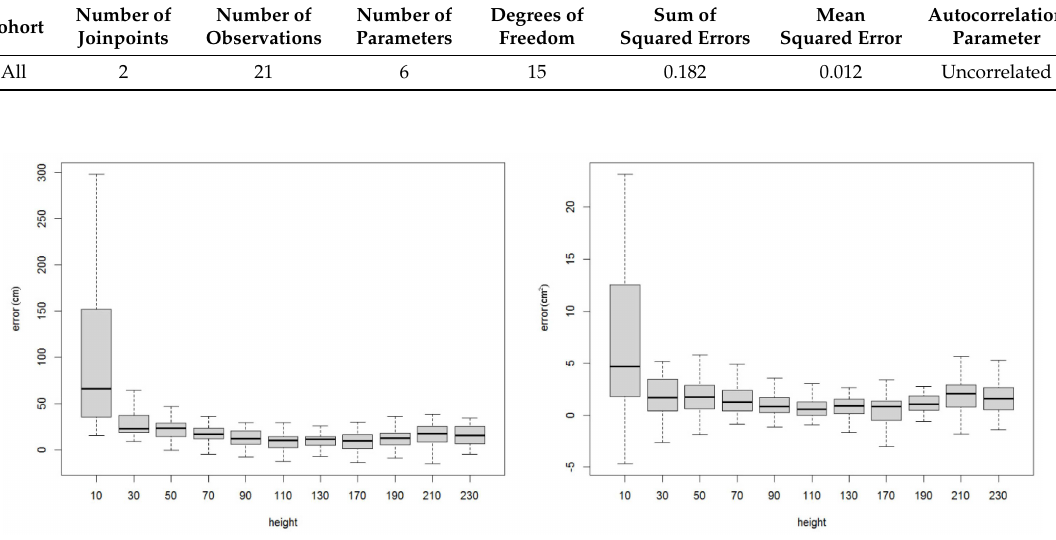
Figure 7. The error in circumference (cm) by height ( left ) and stem sectional area (cm 2 ) by height ( right